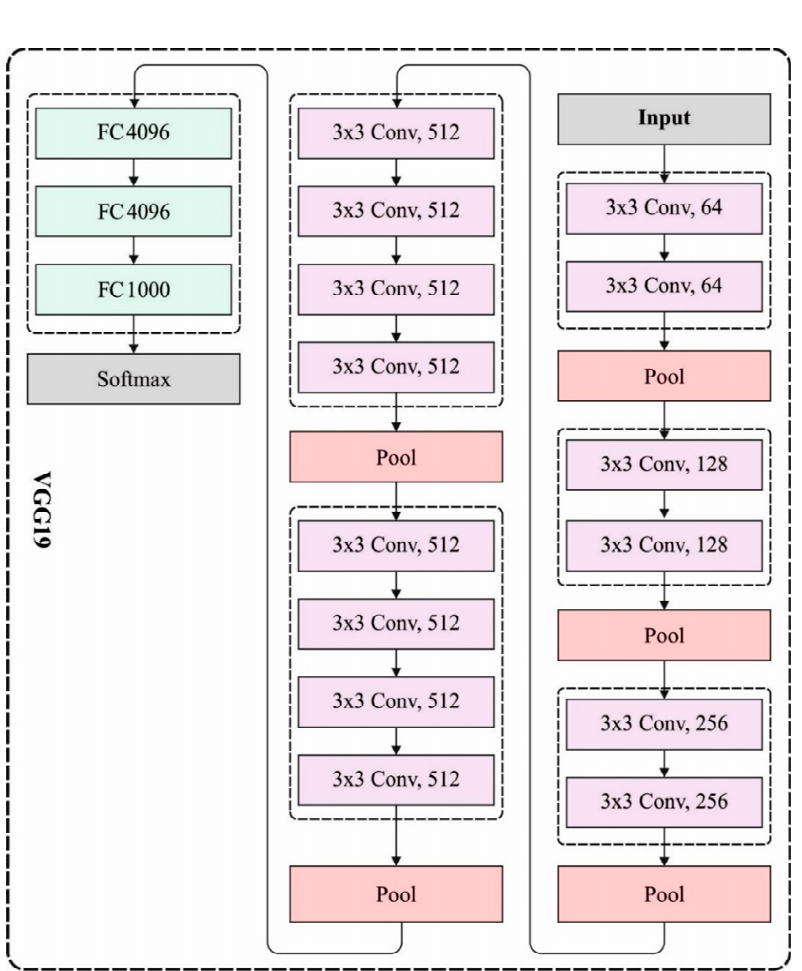
Figure 2. VGG-19 Architecture.